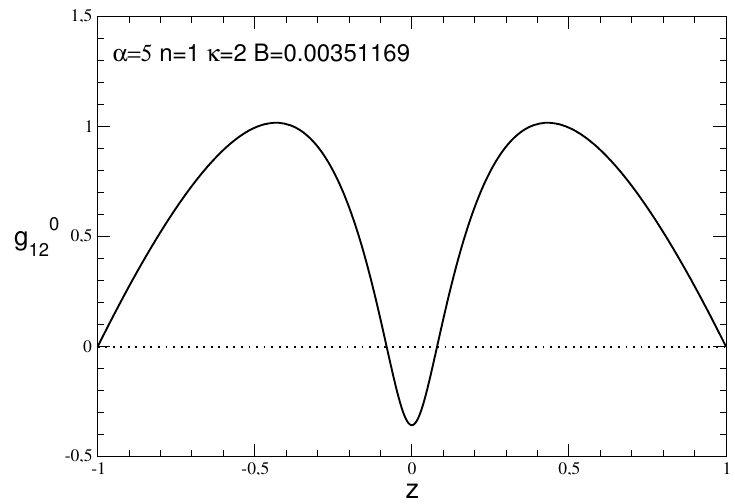
Figure 4. g 0 for state No. 1 ( κ = 0, normal) from Table 1. (Adapted from [1]). 10